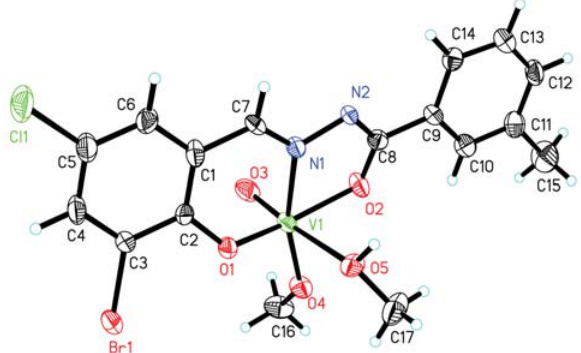
Figure 1. A perspective view of the molecular structure of the com- plex. Thermal ellipsoids are drawn at the 30% probability level.